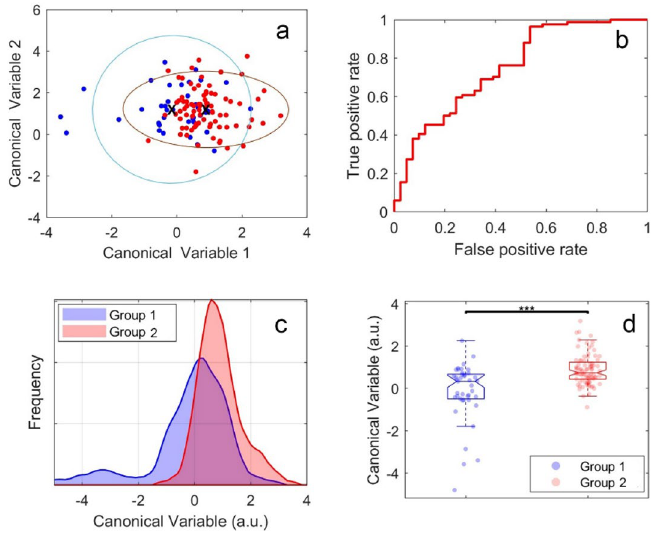
Figure 5. Differentiation of cells from patients with low and high eGFR levels by using six features selected from channel intensities and their ratios. ( a ) Clustering of cells in the two cell groups (group 1: n = 41 cells and group 2: n = 84 cells) under investigation. Symbols represent individual cells. ( b ) ROC curve for our obtained cell classifier (AUC = 0.75), ( c ) cell distribution histogram. ( d ) Boxplots corresponding to the cell classifier evaluated in ( b ). Symbols represent individual cells, p < 0.001.